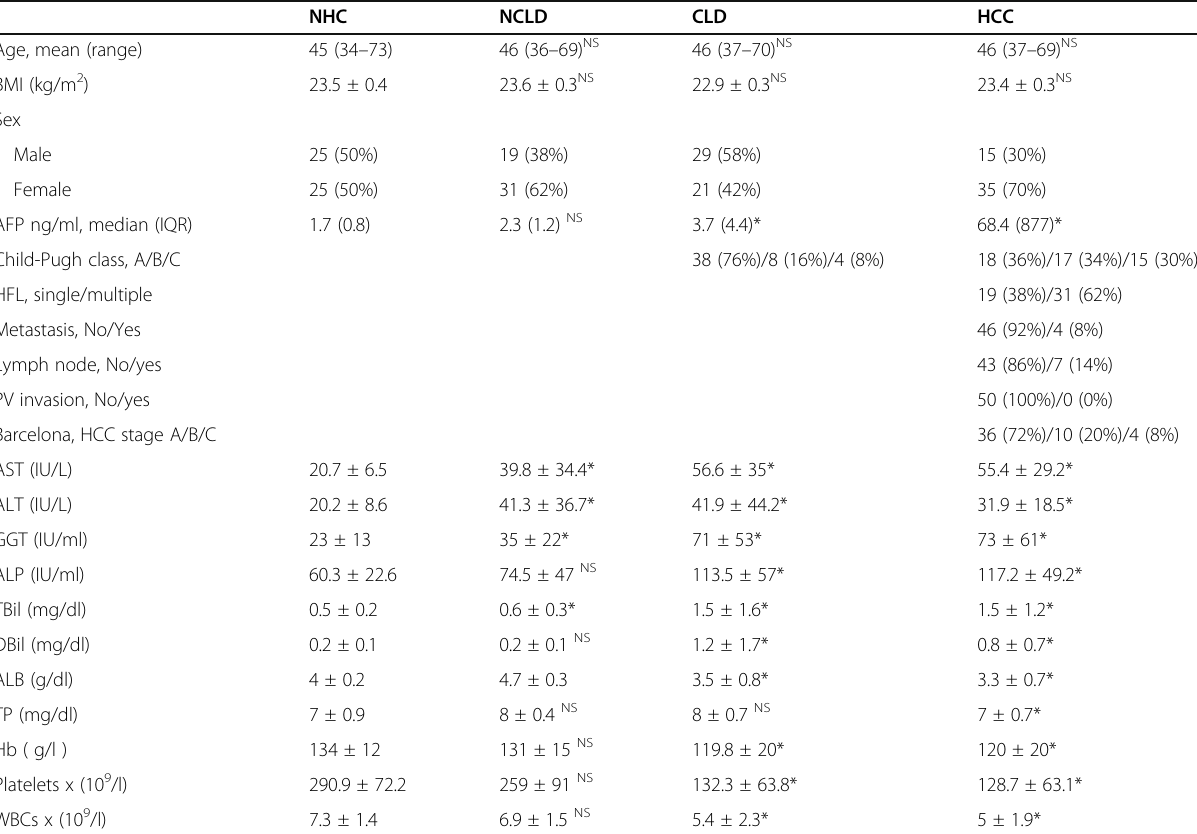
Table 1 Demographic, clinical, and hematological parameter of the enrolled